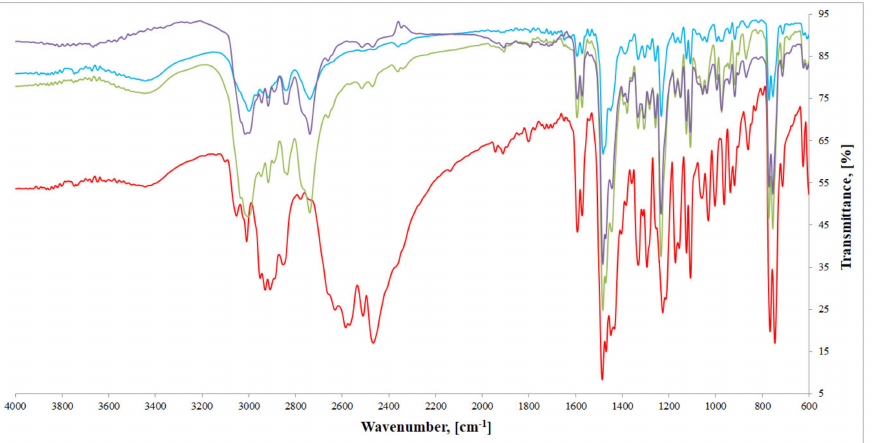
Figure 4. FTIR spectra of investigated compounds: [HL] 2+ [CuCl 4 ] 2 − (blue), [HL] 2+ [ZnCl 4 ] 2 − (green),